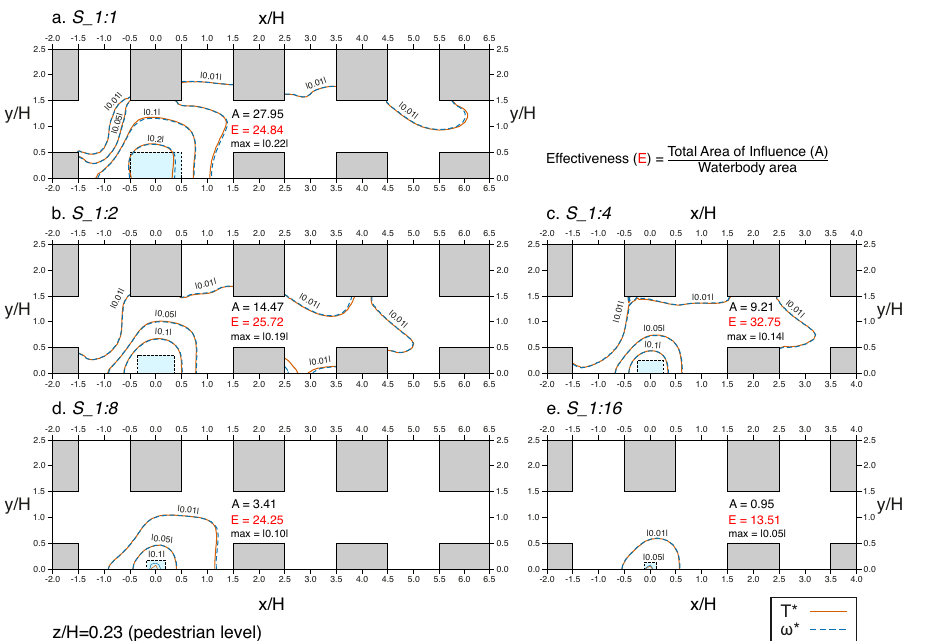
Figure 12. Contours of normalised temperature ( T ∗ ) and water vapour concentration ( ω ∗ ) over a horizontal plane at pedestrian level ( z / H = 0.23) for the cool water body cases ( ∆ T = − 2 K) and different water body sizes: ( a ) original size ( s_1:1 ); ( b ) half the original size ( s_1:2 ); ( c ) a quarter of the original size ( s_1:4 ); ( d ) one-eighth of the original size ( s_1:8 ); ( e ) one-sixteenth of the original size ( S_1:16